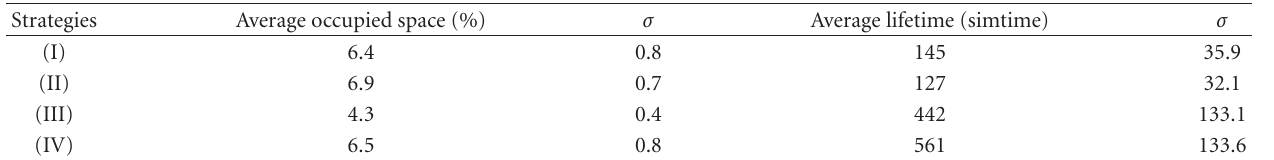
Table 2: Evaluation of di ff erent strategies.